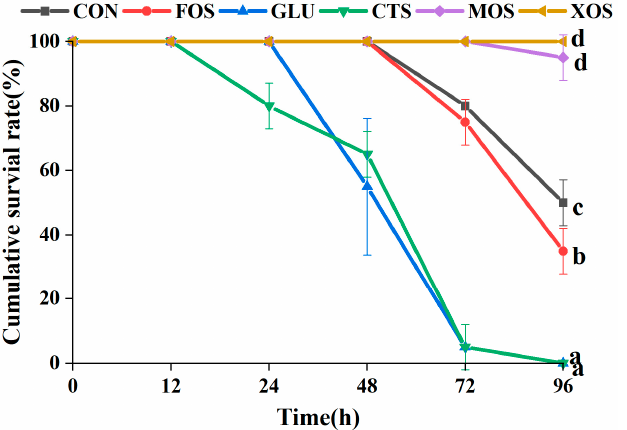
Figure 5. Effects of different prebiotics on the survival rate of hybrid grouper after 96 h ammonia